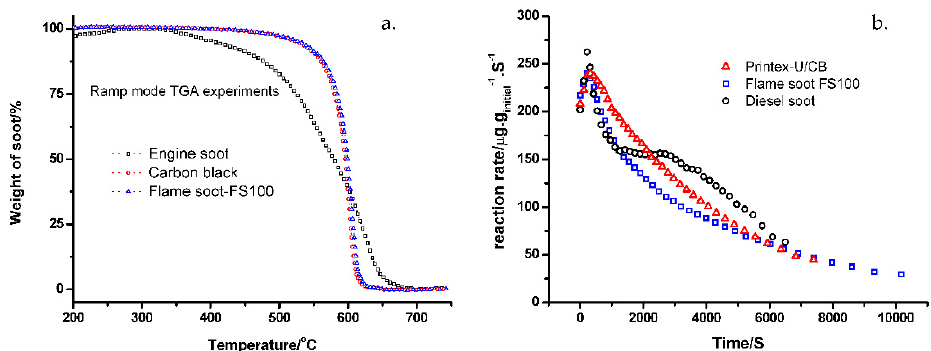
Figure 5. Non-catalytic oxidation experiments for Printex-U carbon black, FS100, and diesel engine soot. ( a ) Ramp mode TGA curves; ( b ) Typical oxidation behavior for isothermal experiments at 525 °C. Feed: 10% O 2 .